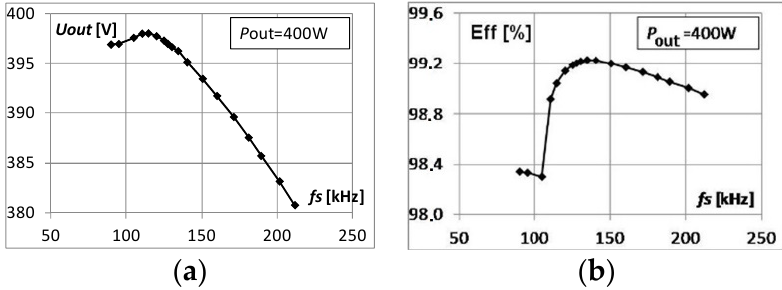
Figure 13. ( a ) Output voltage U out and ( b ) efficiency of SCVD as a function of switching frequency f S . U in = 200 V, P out = 400 W, t M = 50 ns. Switching pattern P1 (for f S < f 0 ) and P2 (for f S > f 0 ).